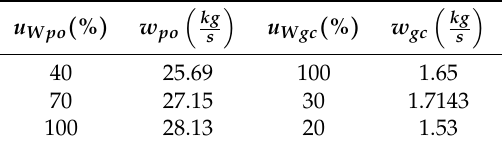
Table 3. Maximum values of w po and w gc at the gain signal inversion region.